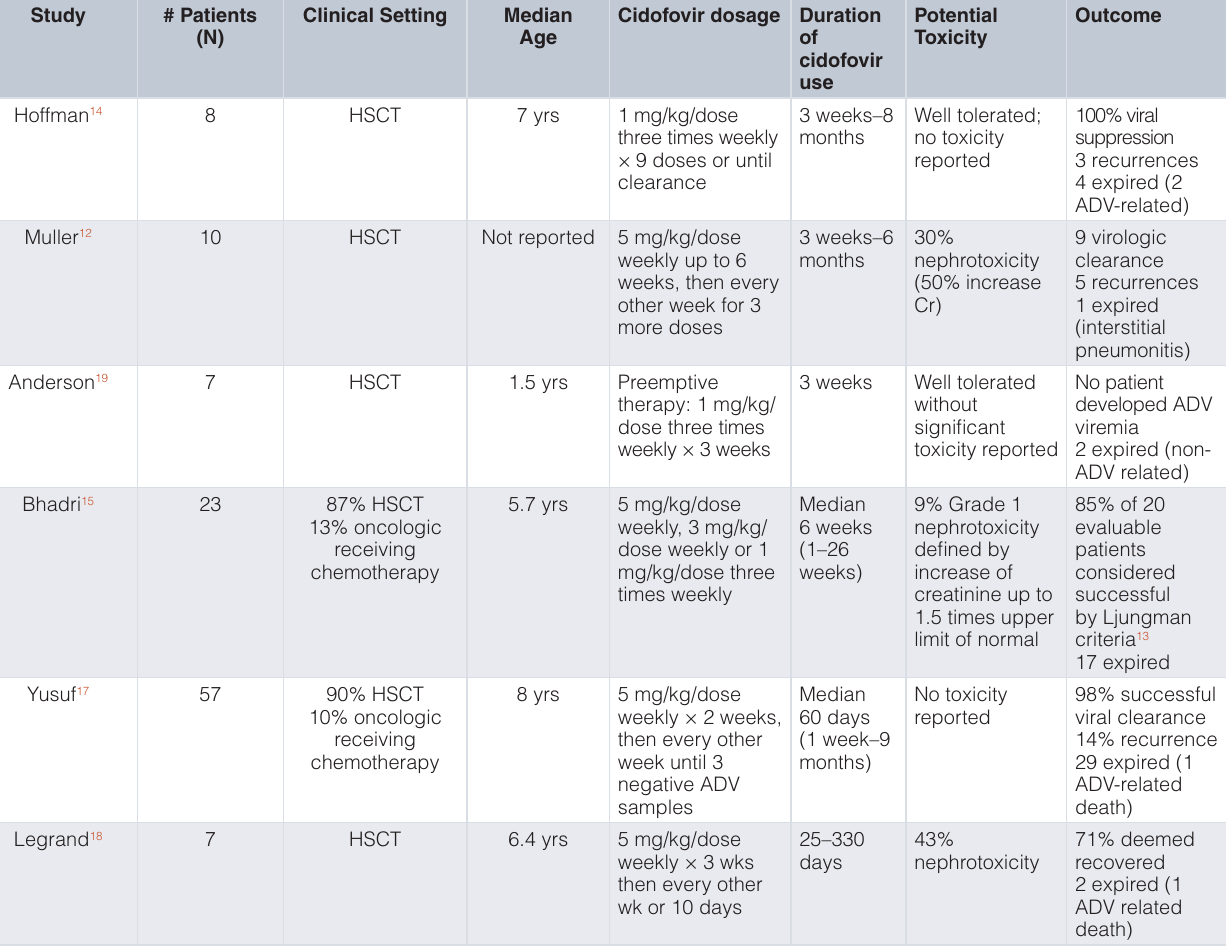
Table 3. Summary of studies describing use of cidofovir in pediatric HSCT and SOT recipient. Published studies in the literature describing use of cidofovir in pediatric HSCT and SOT recipients are summarized. Toxicities, and clinical outcomes reported in each study are